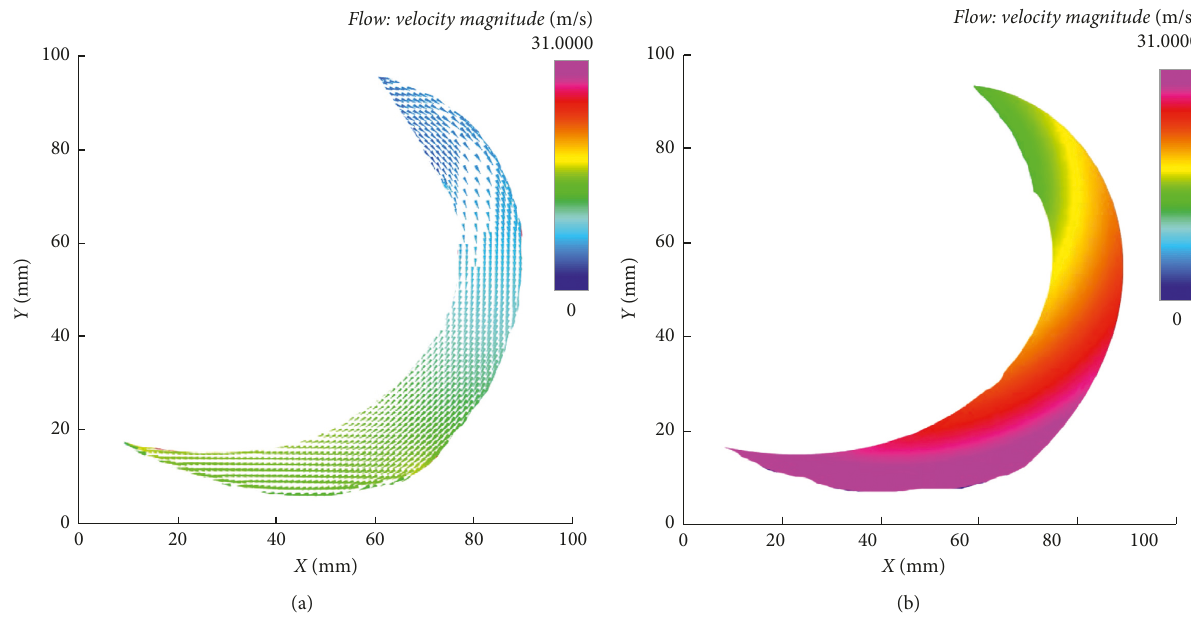
Figure 10: Optimization pump relative speed velocity (a) vector diagram and (b) cloud